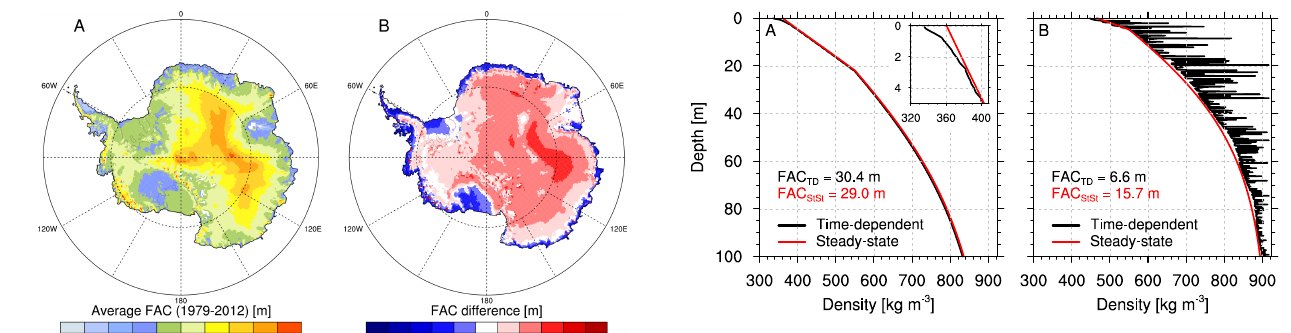
Figure 2. Typical firn density profiles for two locations in Antarc- tica; one without snowmelt (a) on the East Antarctic plateau (85 ◦ S, 84 ◦ E) and one with significant summer snowmelt (b) near George VI ice shelf (73 ◦ S, 67 ◦ W). For both locations, the steady-state (“StSt”, red) and time-dependent (“TD”, black) solutions of the FDM are shown, with in (a) an inset showing the first 5m, as well as the firn air content (FAC) for both